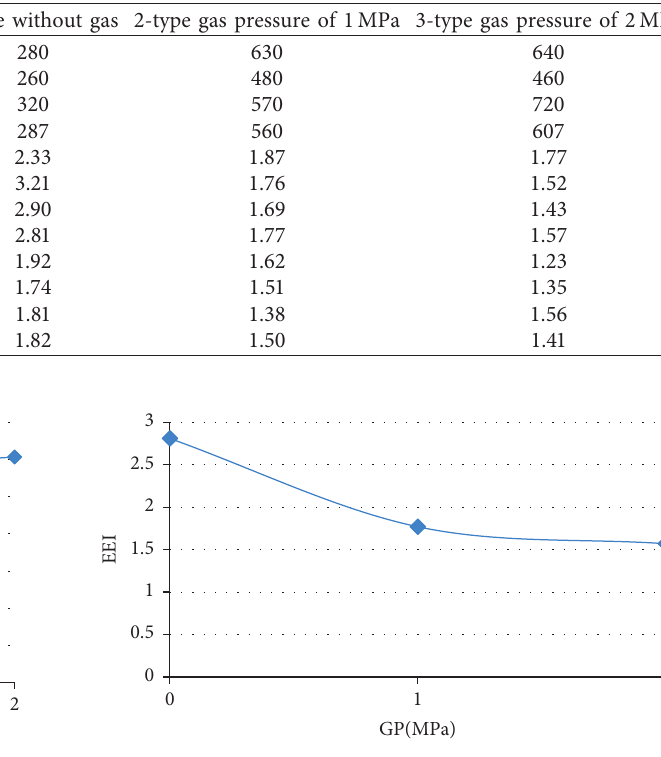
Figure 20: Variation in dynamic fracture time with changing gas pressure.